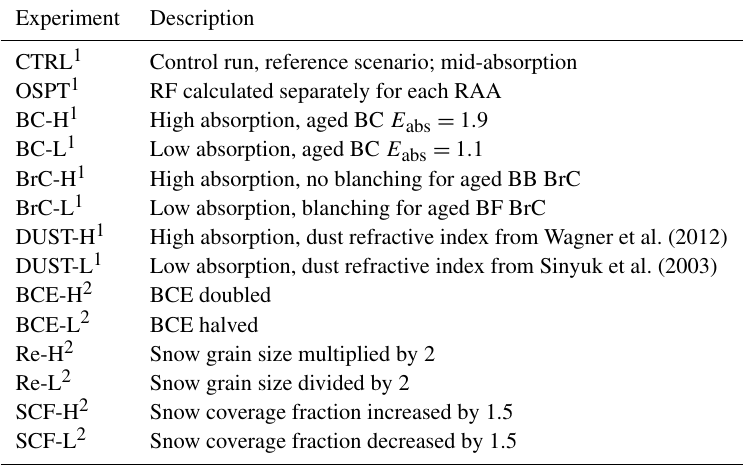
Table 1. Summary of the numerical experiments. Experiment